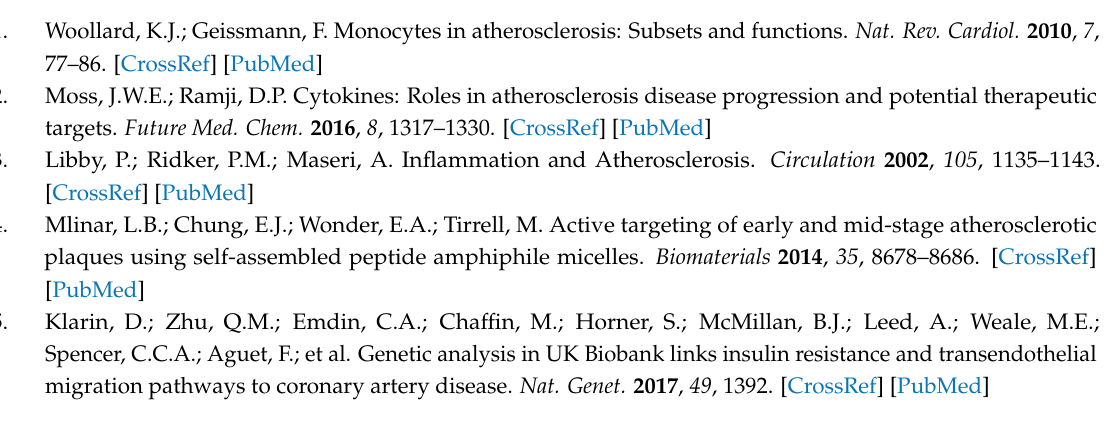
Figure S1: Characterization of (a) MNPs and (b) MCP-1-motif MNPs using SEM, Figure S2: Hydrodynamic distribution of (a) MNPs and (b) MCP-1-motif MNPs by DLS, Figure S3: Live/Dead assay of cells with MCP-1-motif MNPs at day 1, Figure S4: Live/Dead assay of cells with MCP-1-motif MNPs at day 4, Figure S5: Cell counting of (a) WEHI 274.1 monocytes and (b) 3T3 cells. ( n = 3), Figure S6: (a) Fluorescence image and (b) merged image of the Cy5-MCP-1-motif MNPs, Figure S7: Fluorescence image of (a) 3T3 cells and (b) WEHI 274.1 monocytes cultured with Cy5-MCP-1-motif MNPs, Figure S8: IVIS body fluorescence of ApoE KO mice and wild-type mice injected with PBS from 0- to 72-h injection, Figure S9: Prussian Blue and hematoxylin staining of kidney of (a–c) ApoE KO mice and (d–f) wild-type mice (scale bar = 50 µ m), Table S1. Bond composition ratios of the iron oxide